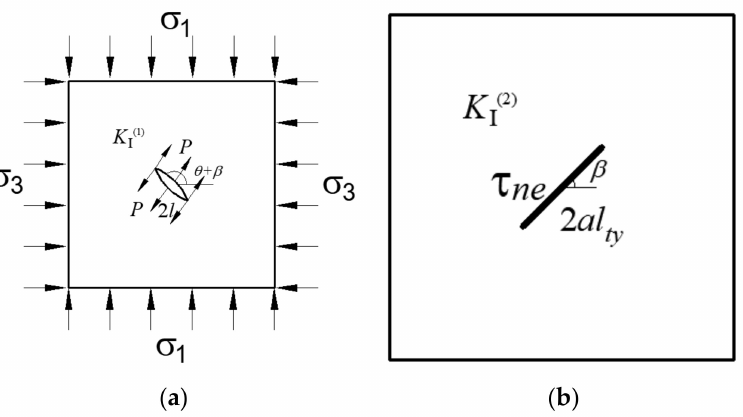
Figure 5. Superposition of stress intensity factor of wing crack under high hydraulic pressure.